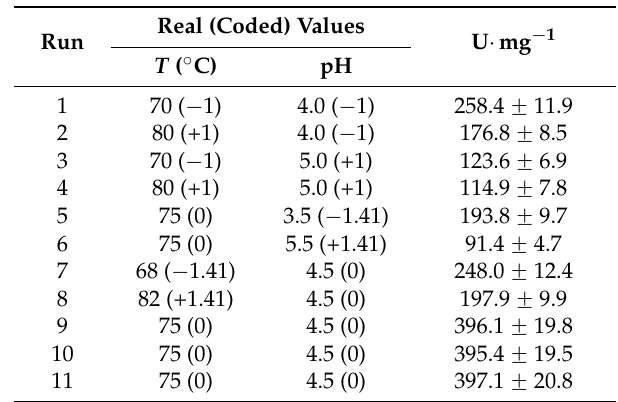
Table 5. Experimental conditions and results of the statistical experimental design for the laccase activity.